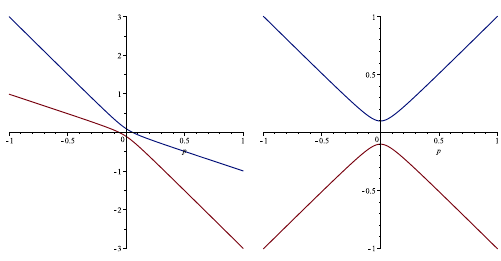
Figure 1. Energy of Dirac fermions as a function of momentum in the Painleve–Gullstrand (PG) coordinate frame. The vertical axis corresponds to energy while the horizontal axis corresponds to momentum. ( Left ) Inside the horizon of the BH. The states along the lower line are occupied. There is a piece of this line above zero. The corresponding particles tunnel through the horizon toward the exterior of the BH. ( Right ) Outside of the external horizon. Again, the lower branch is occupied, but it remains completely below zero.